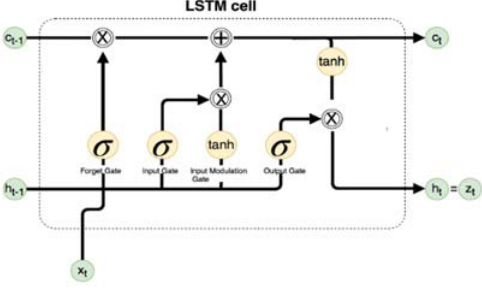
Figure 2. Information flow in a long short ‐ term memory (LSTM) block of the RNN.